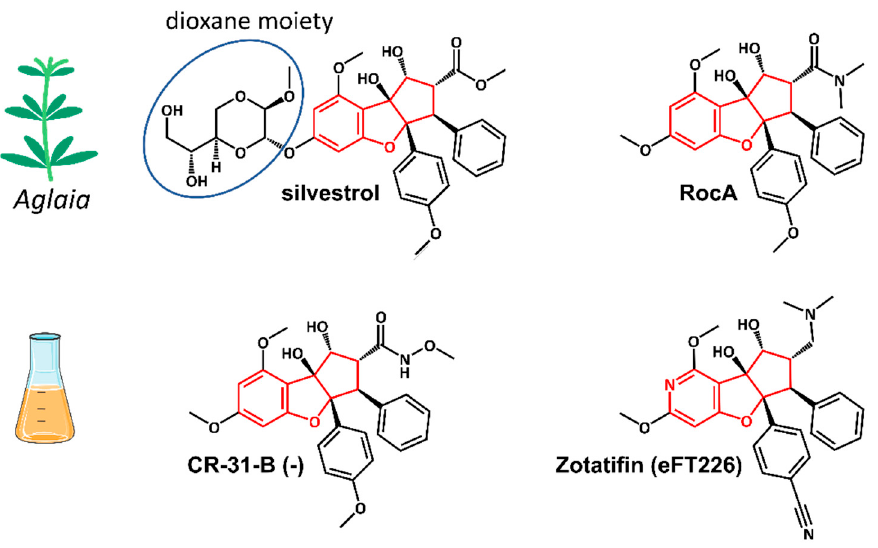
Figure 4. Structures of the natural rocaglates silvestrol and rocaglamide A (RocA) and the synthetic rocaglates CR-31-B (-) and Zotatifin (eFT226). The typical cyclopenta[ b ]benzofurane skeleton is indicated in red. The blue ring shows the dioxane moiety that is only found in silvestrol and its diastereomer episilvestrol.